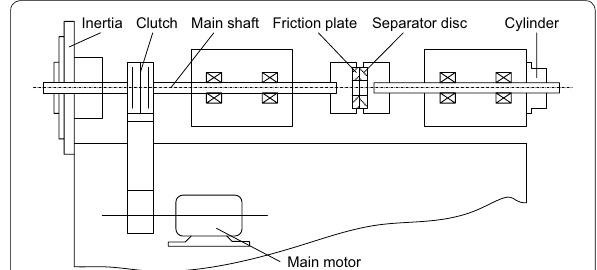
Figure 4 Structure of MM1000-III friction and wear testing